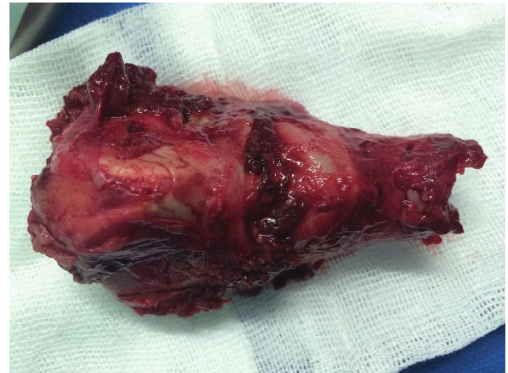
Figure 3: Larynx specimen after transoral laser-assisted total laryngectomy (TLM-TL).